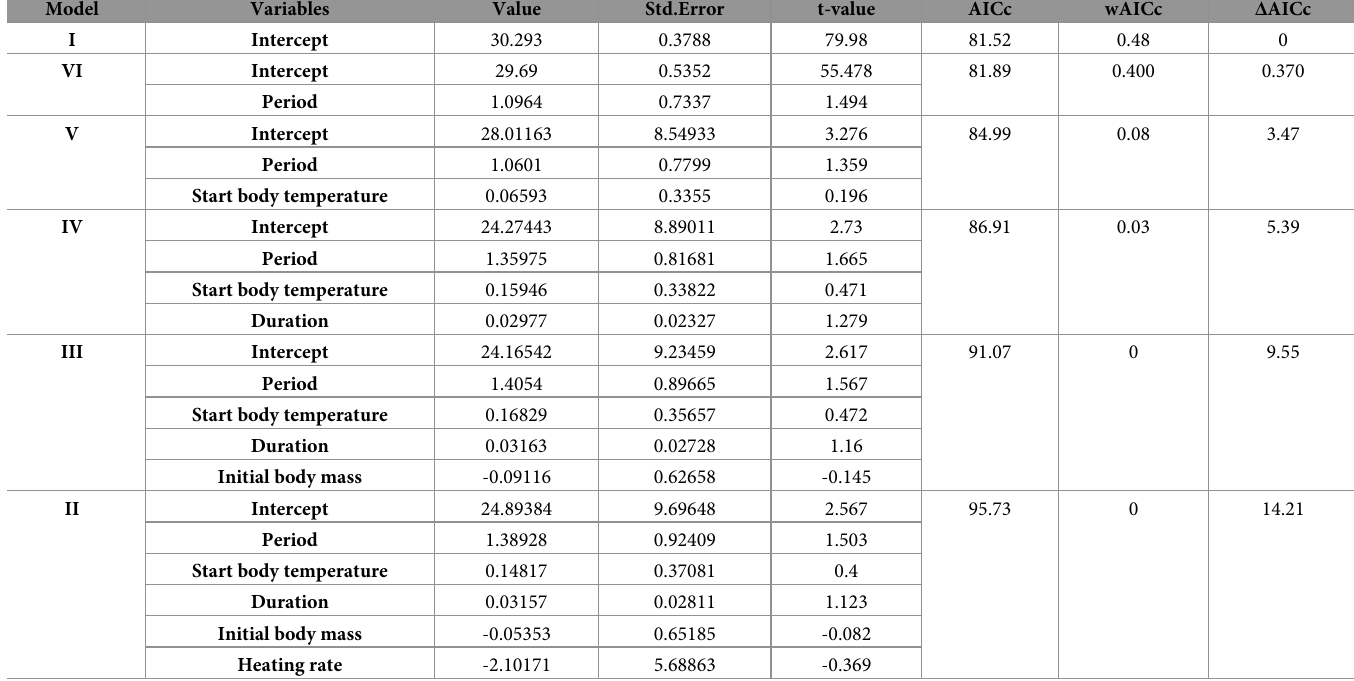
Table 3. Effect of period, start body temperature, duration, initial body mass, and heating rate on the Voluntary Thermal Maximum (VT Max ) of P . cuvieri from Estac¸ ã o Ecolo´gica de Santa Ba´rbara, state of S ã o Paulo,